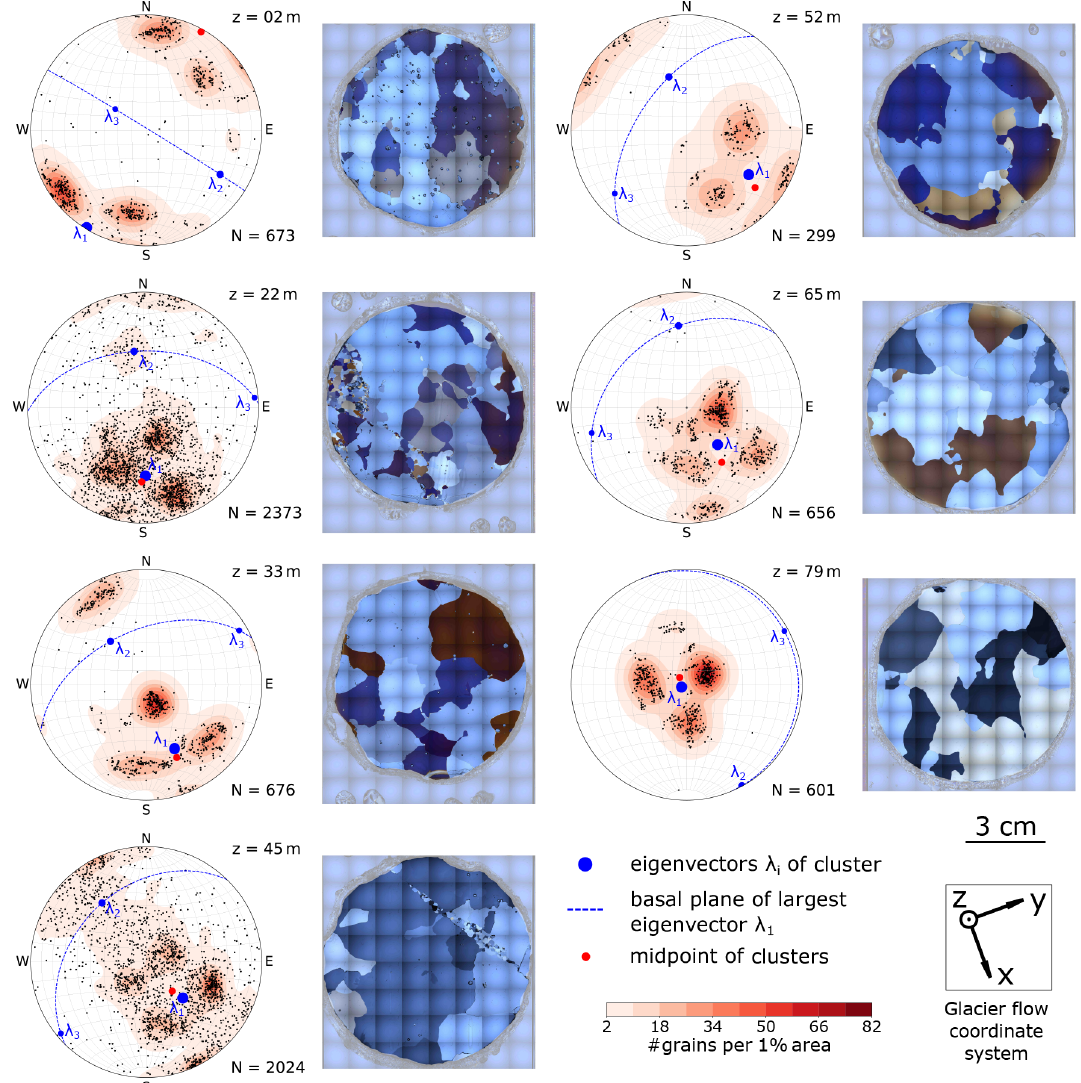
Figure 5. Left columns: stereo-plots (lower-hemisphere Schmidt equal-area projection onto the horizontal, i.e. long axis of core plots in the centre) with the c -axis distribution and associated horizontal thin sections, illustrating the typical grain size distribution, shown for each sample. The total number of ice grains ( N ) is specified for each sample (consisting of at least three horizontal and six vertical thin sections, all rotated to a horizontal view and common geographic coordinates). The sampling depth ( z ) is indicated in the upper right corner of the stereo-plots. The colour code (smoothed Kamb’s distribution; Vollmer, 1995) emphasises the existing clusters of the c -axis distribution. The eigenvectors for the determined distribution are depicted as blue dots, and the normal plane of the largest eigenvector is shown as a dashed line. Right columns: example images of horizontal thin sections, recorded under cross-polarised light; pale edges around the actual samples are excluded from